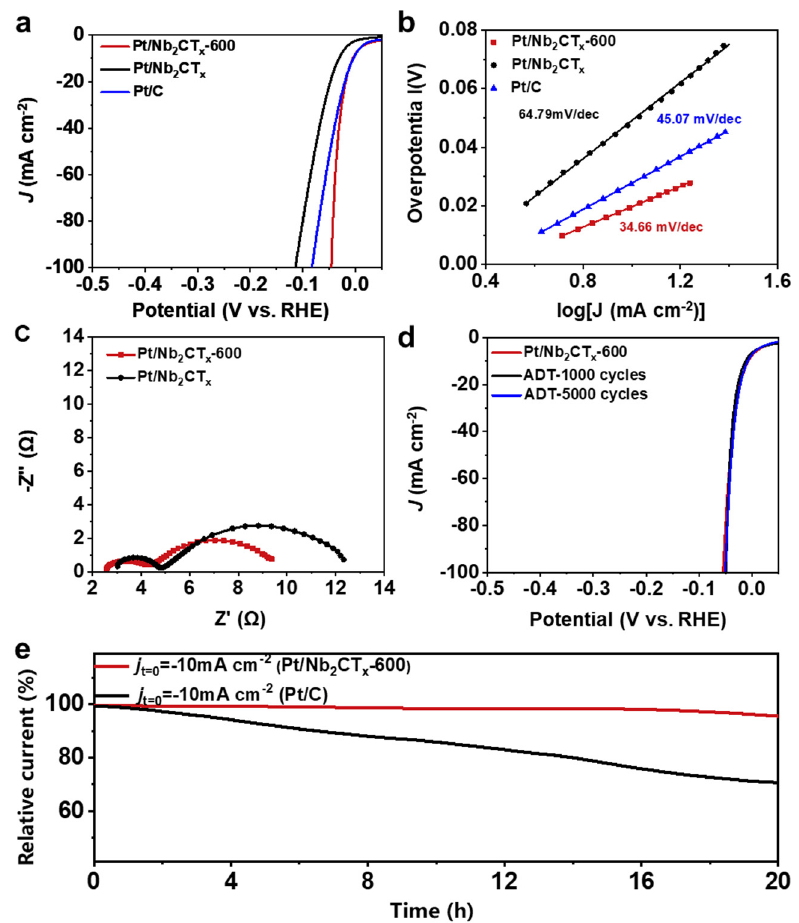
Figure 4. Electrocatalytic HER performance of different catalysts in 0.5 M H 2 SO 4 . ( a ) Polarization curves of the Pt/Nb 2 CT x , Pt/Nb 2 CT X -600, commercial Pt/C catalysts. ( b ) Tafel plots of the Pt/Nb 2 CT x , Pt/Nb 2 CT X -600, commercial Pt/C catalysts. ( c ) EIS Nyquist plots for HER performance of the Pt/Nb 2 CT x and Pt/Nb 2 CT X -600 catalysts. ( d ) ADT tests for HER performance of Pt/Nb 2 CT X -600 catalyst. ( e ) CA curves of Pt/Nb 2 CT x and Pt/C catalysts for HER performance.